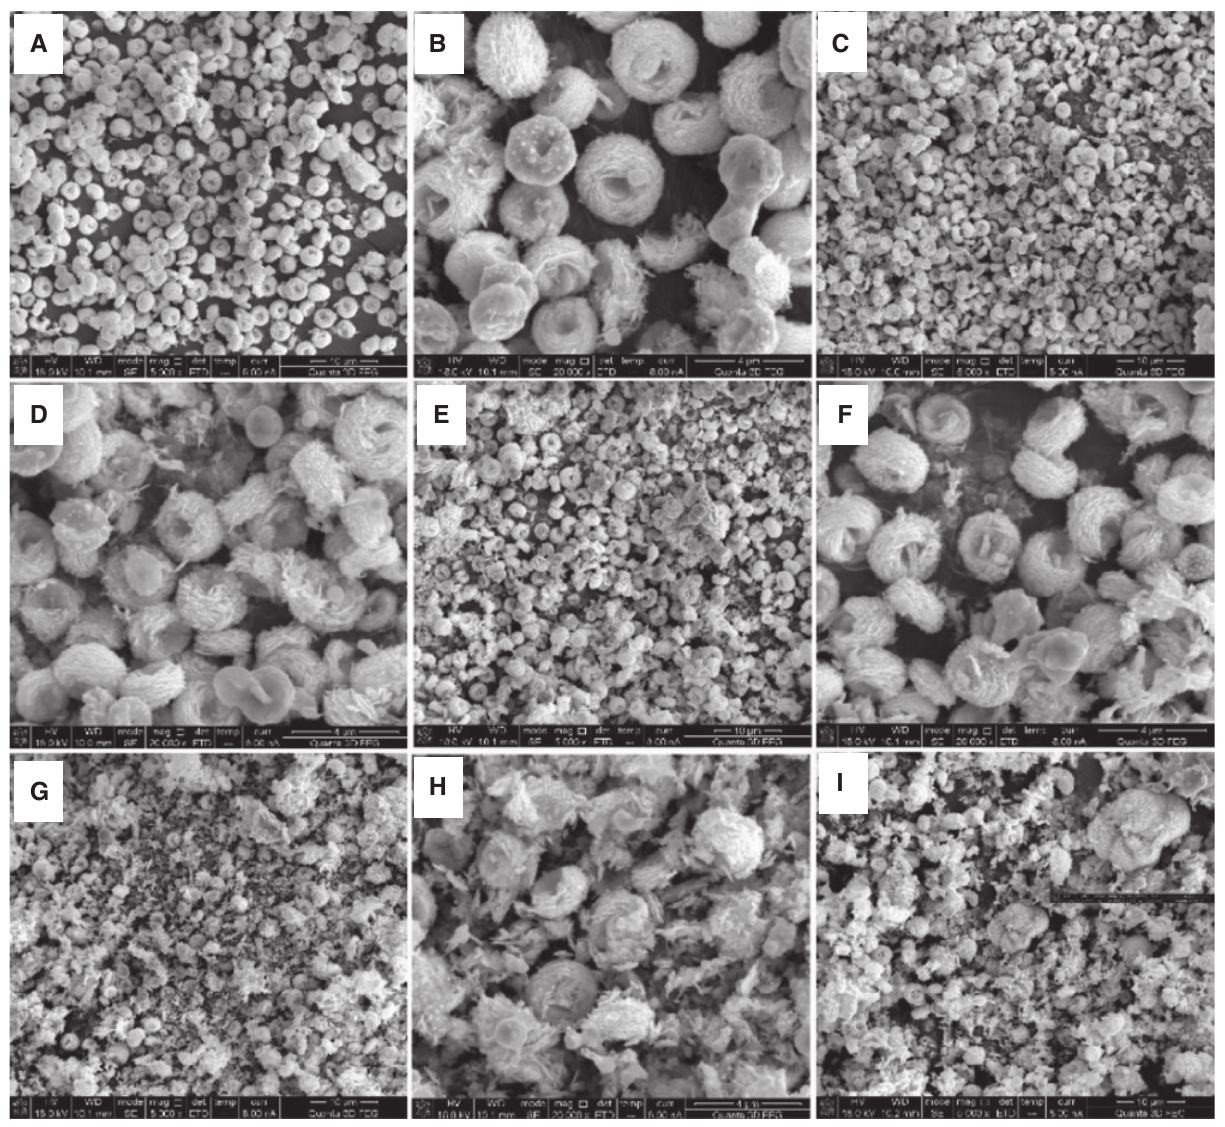
= 2%; (C) R = 4%; (E) R = 6%; (G) R = 8%; (I) R = 10%. values: (A) R M M M M M M